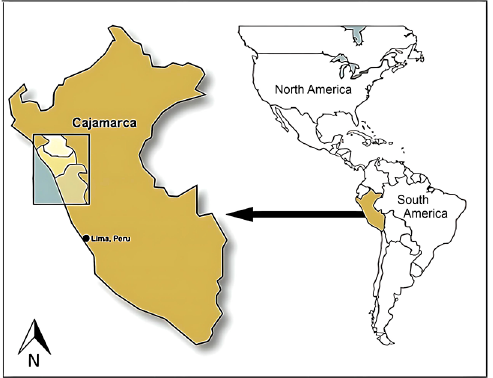
Figure 1. Gold mine location map in the northern highlands of Peru.